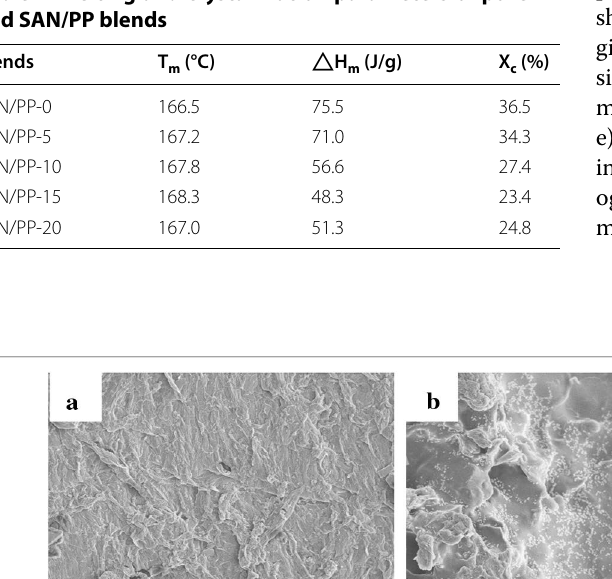
( a ) and 10 wt% SAN/PP blends 2000 × ( e ) and 20 wt% SAN/PP 10,000 ×